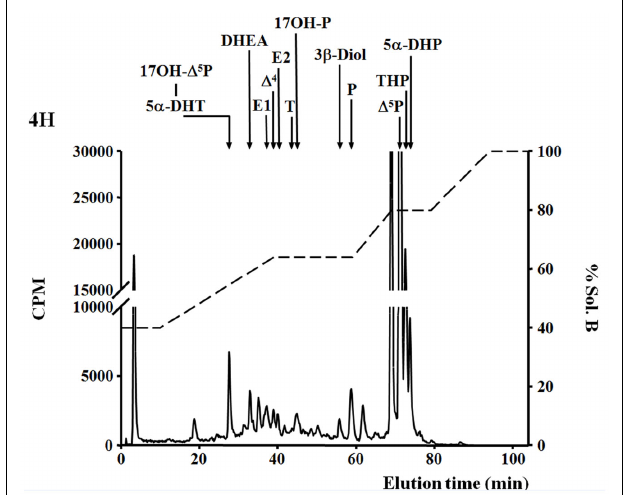
FIGURE 1 | De novo steroid synthesis by the brain of adult zebrafish. RP-HPLC analysis of radioactive steroids formed after a 4h incubation of 14 adult zebrafish brains with [ 3 H]-pregnenolone ([ 3 H]- Δ 5 P).The ordinate axis indicates the radioactivity measured in the HPLC eluent.The dashed lines represent the gradient of secondary solvent (% solution B).The arrows indicate the elution positions of standard steroids: 17OH- Δ 5 P, 17-hydroxypregnenolone; 5 α -DHP, 5 α -dihydro-progesterone; 5 α -DHT, 5 α -dihydro-testosterone; DHEA, dehydroepiandrosterone; Δ 4 , androstenedione;T, testosterone; 17OH-P, 17-hydroxyprogesterone; P, progesterone; Δ 5 P, pregnenolone; E1, estrone; E2, 17 β estradiol; 3 β -diol, α -Androstane-3 β , 17 β -diol;THP, tetrahydro-progesterone. number of other compounds ( Figure 1 ) (Diotel et al.,